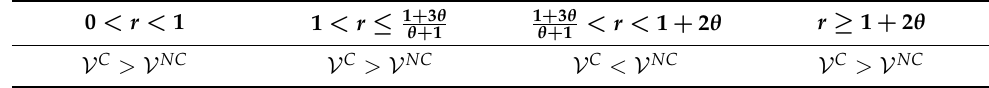
Table 1. Comparison of NVI for 0 < θ ≤ 1.